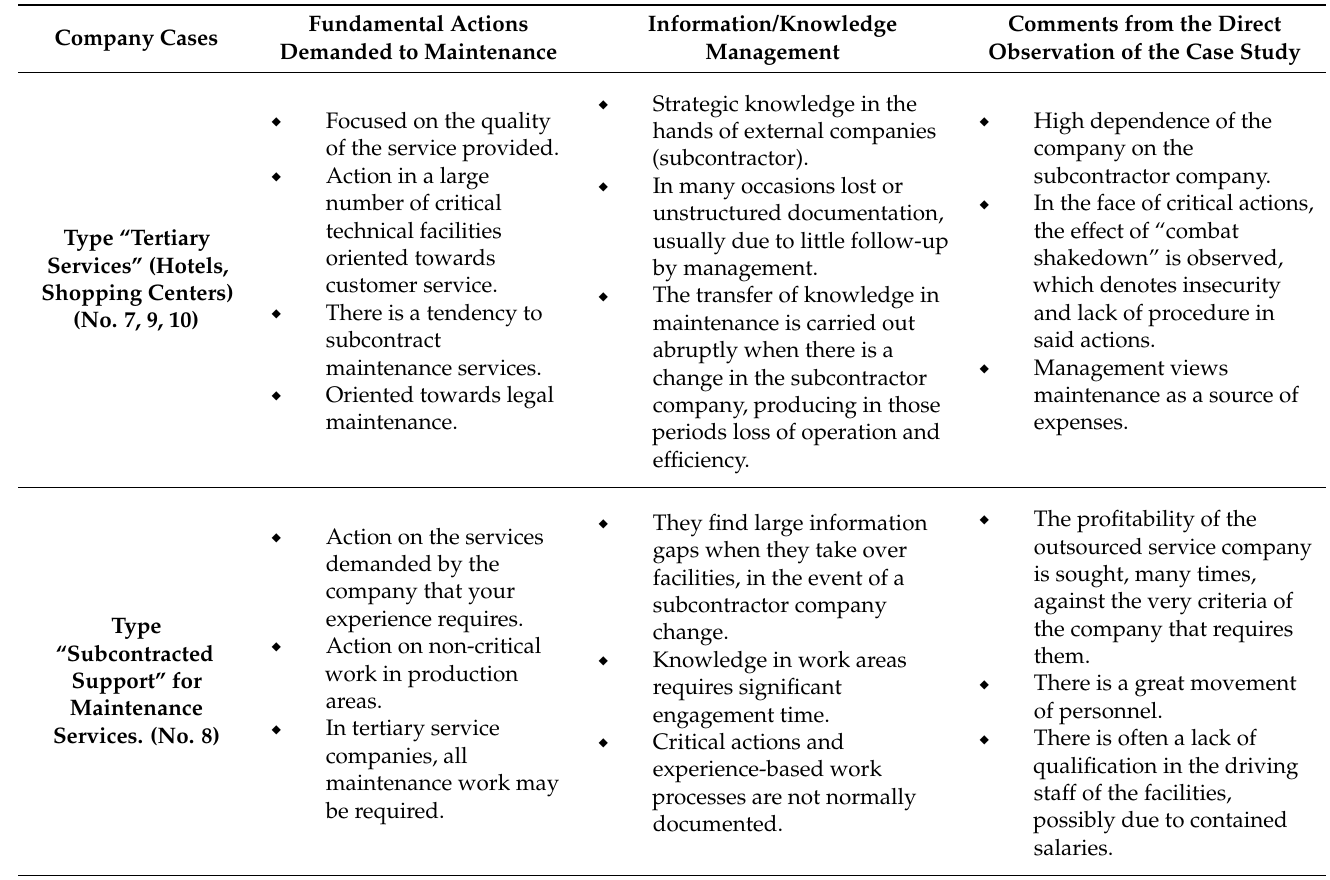
Table 2. Characteristics observed in the case study in reference to maintenance.